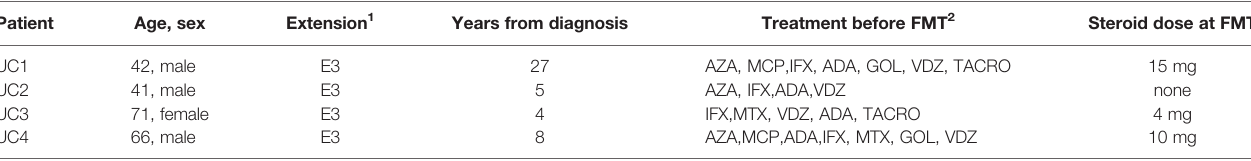
TABLE 1 | Clinical characteristics of the four patients with ulcerative